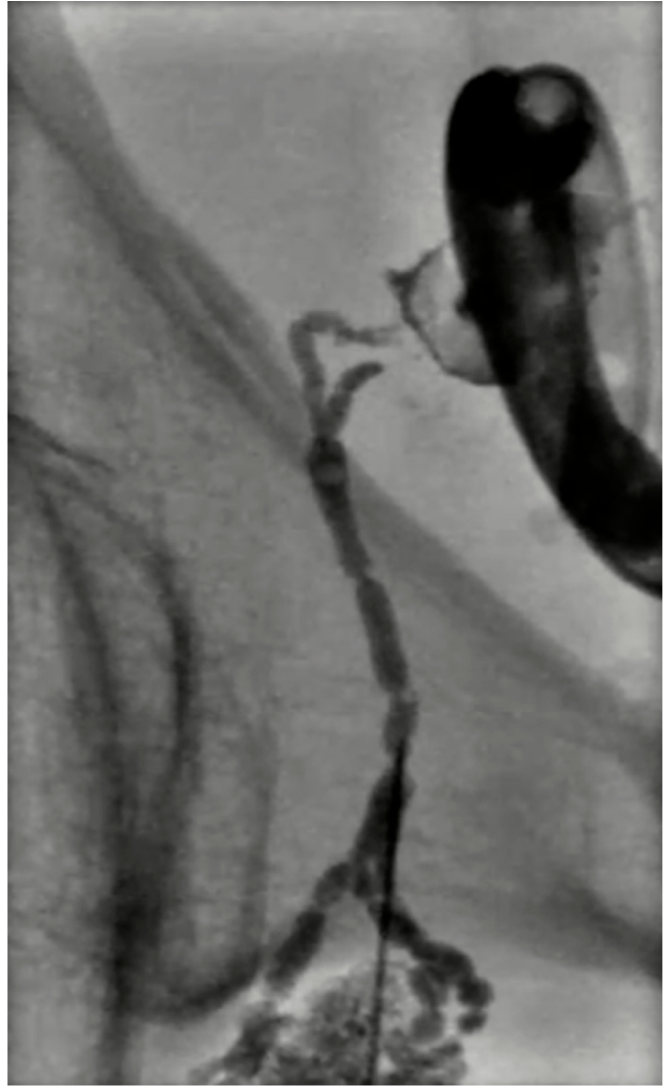
Figure 9. Digital subtraction lymphangiography of a 54-year-old male with lymphocele after pros- tatectomy. A percutaneous drainage catheter was placed in the lymphocele; then a right obturatory lymphangiography and lymphatic embolization with cyanoacrylate were performed. The percuta- neous drainage catheter was removed 2 days later.